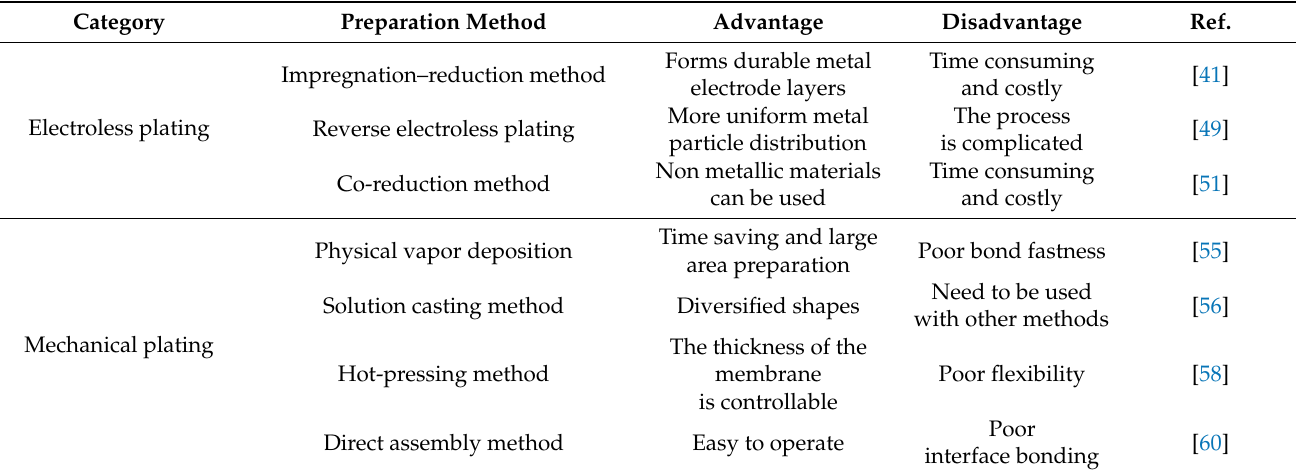
Table 3. Comparison of IPMC preparation